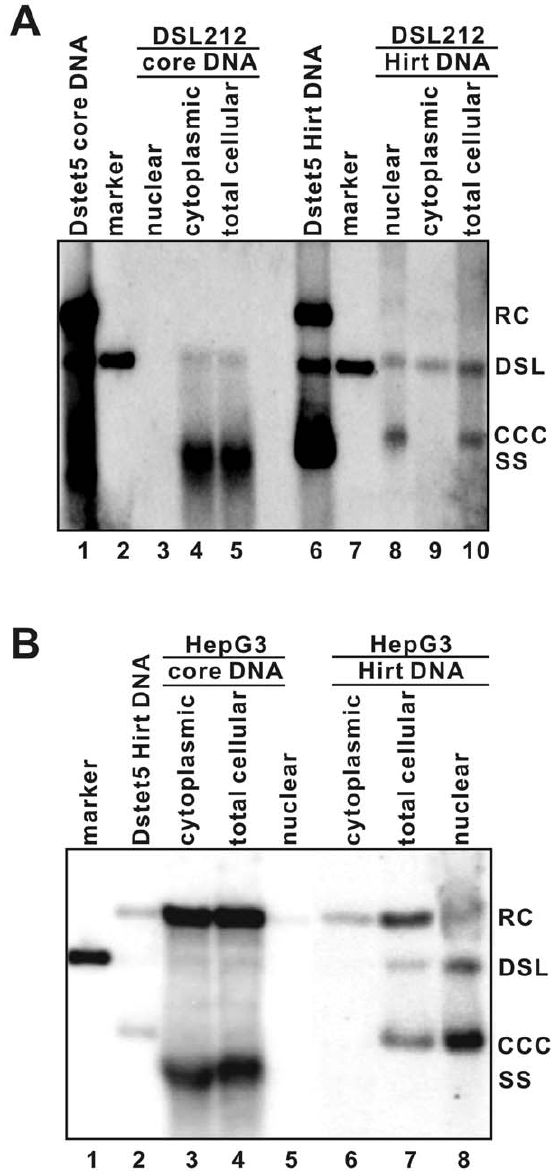
intermediates in HepG2 cells. (A) DSL212 cells were cultured in the absence of tetracycline for 6 days. Cytoplasm and nuclei were fractionated with QIAgen Qproteome Cell Compartment Kit by following the manufacturer’s directions. DHBV core-associated DNA and Hirt DNA were extracted from whole cell, cytoplasm and nuclear fractions were analyzed by Southern blot assay. (B) DHBV core- associated DNA and Hirt DNA were extracted from whole cell, cytoplasm and nuclear fractions of HepG3 cells (a HepG2-derived stable cell line containing an integrated DHBV head-to-tail unit-length DNA dimer) were analyzed by Southern blot assay. vector expressing an envelope-null (1S mutant) DHBV pgRNA under the control of CMV-IE promoter (AdDHBV1S) [33]. As shown in Fig. 3, both wild-type CHO (CHO-K1) cells and NHEJ- deficient cell lines supported DHBV DNA replication and cccDNA formation, albeit at a variable efficiency. Because rcDNA, but not dslDNA, is the predominant mature viral DNA form in these AdDHBV1S infected cell lines, the results are